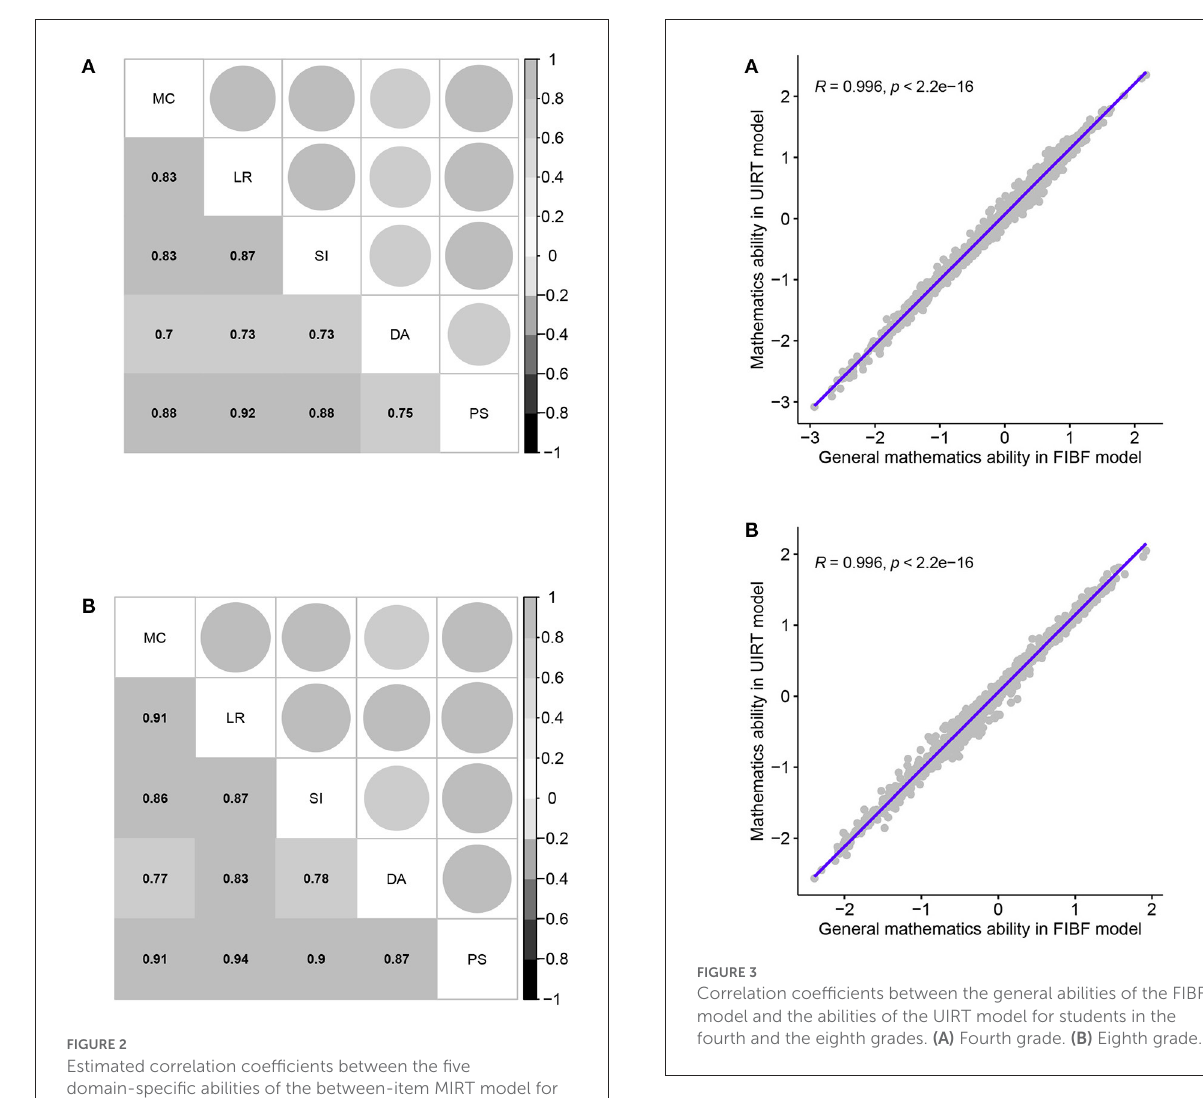
FIGURE2 Estimated correlation coefficients between the five domain-specific abilities of the between-item MIRT model for students in the fourth and eighth grades. MC, mathematical computation; LR, logical reasoning; SI, space imagination; DA, data analysis; PS, problem solving. (A) Fourth grade. (B) Eighth grade.